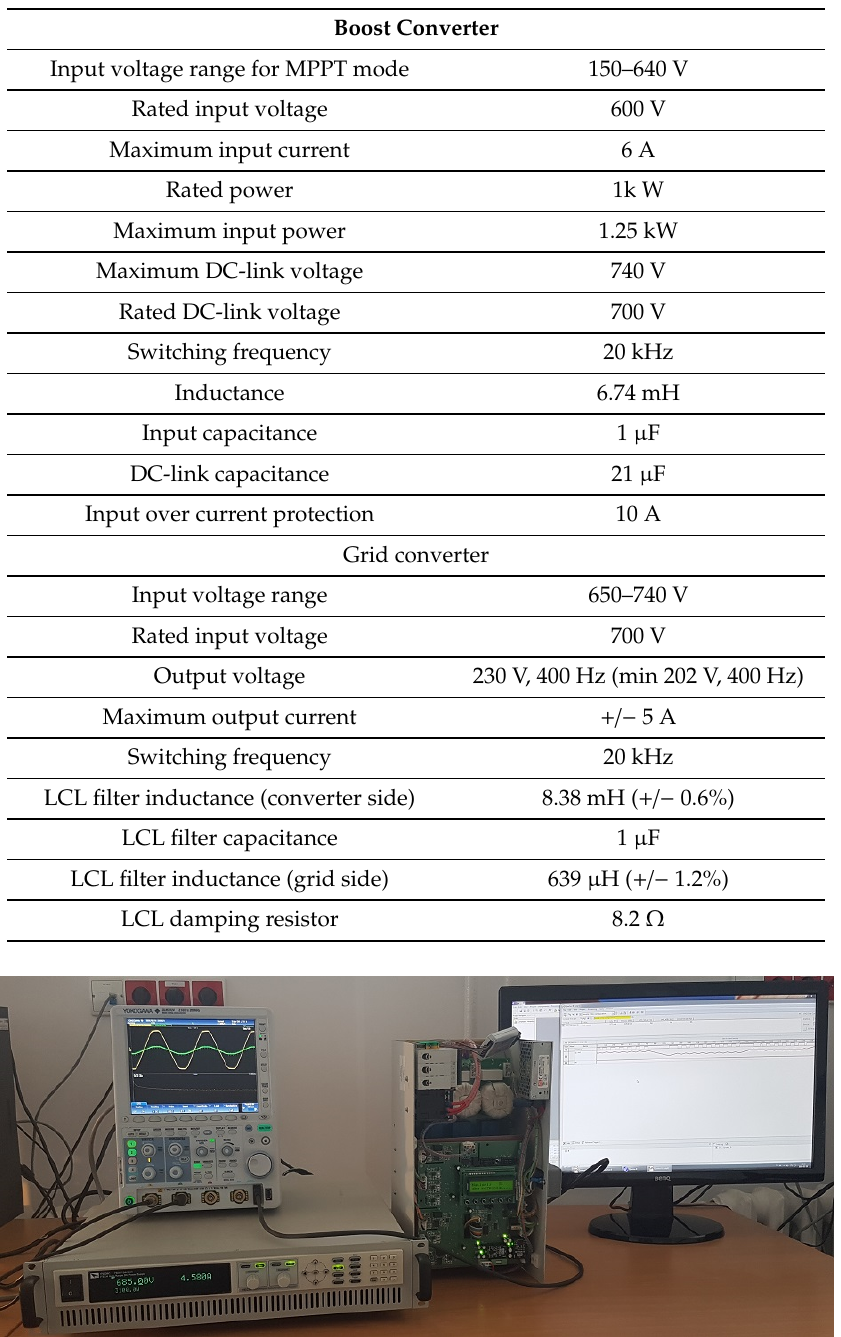
Figure 4. Hardware setup with power converter, photovoltaic panel (PvP) system emulator and Yokogawa mixed signal oscilloscope.